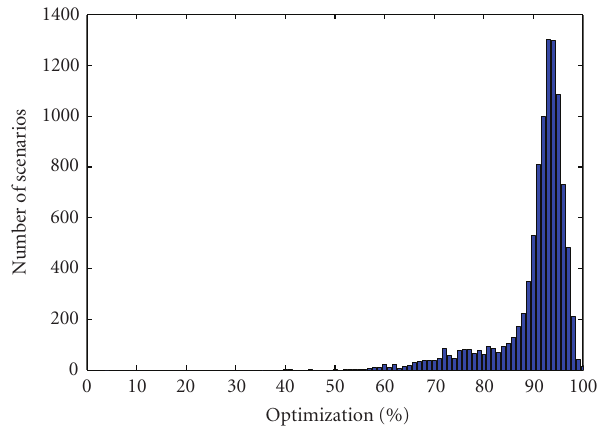
Figure 6: Optimization percentage distribution compared to Matlab minimax solution: an average of 89% and a peak of 93% of optimization are reached.